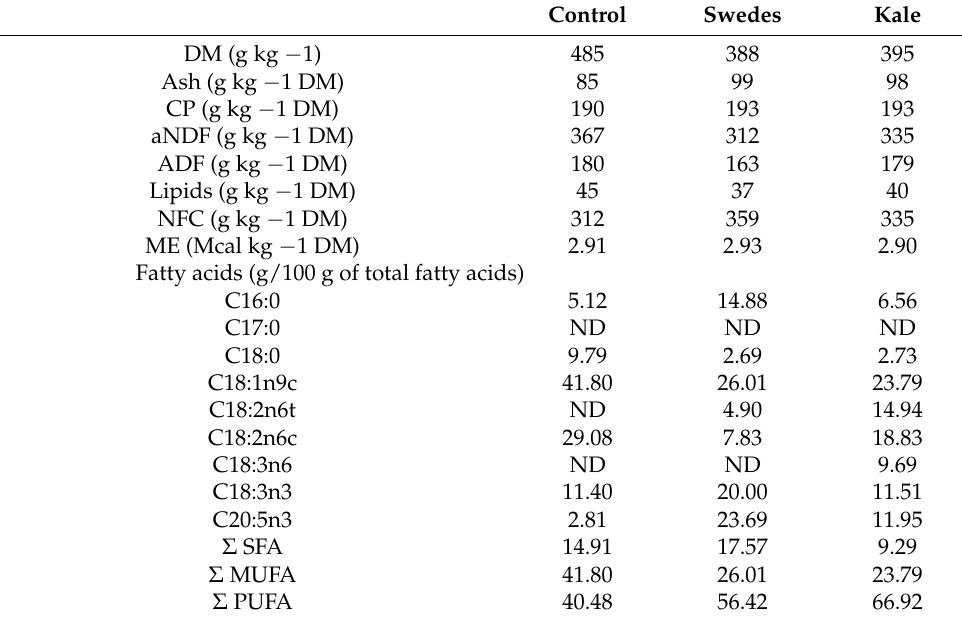
Table 1. Nutrient concentration and fatty acids profile (g/100 g of total fatty acids) of the diets offered to early lactation dairy cattle producing milk to be processed into Chanco-style cheese. Control